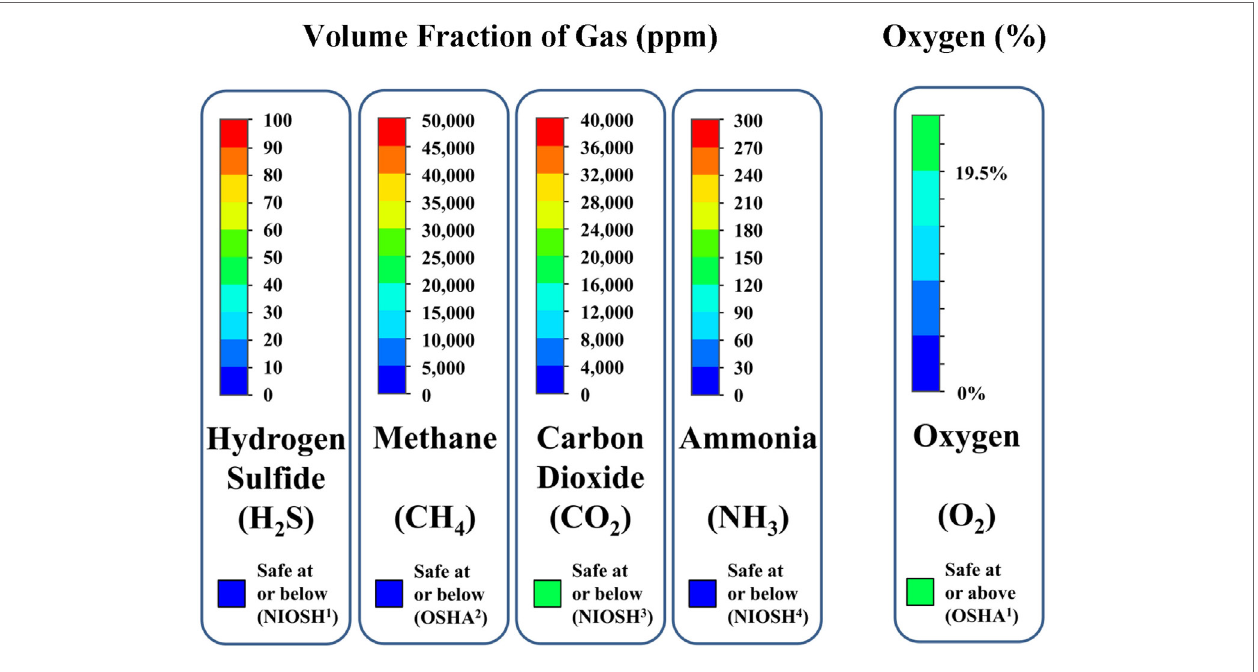
FIgURe 11 | color code legends for interpreting animations of gas concentrations in the manure pit or barn as function of time from commencement of pit ventilation . Red indicates that contaminant gas concentration above potentially lethal limit; blue indicates that contaminant gas concentration is below its TLV or PEL. Green indicates that oxygen levels are 19.5% or higher; blue indicates that oxygen level of 0% by